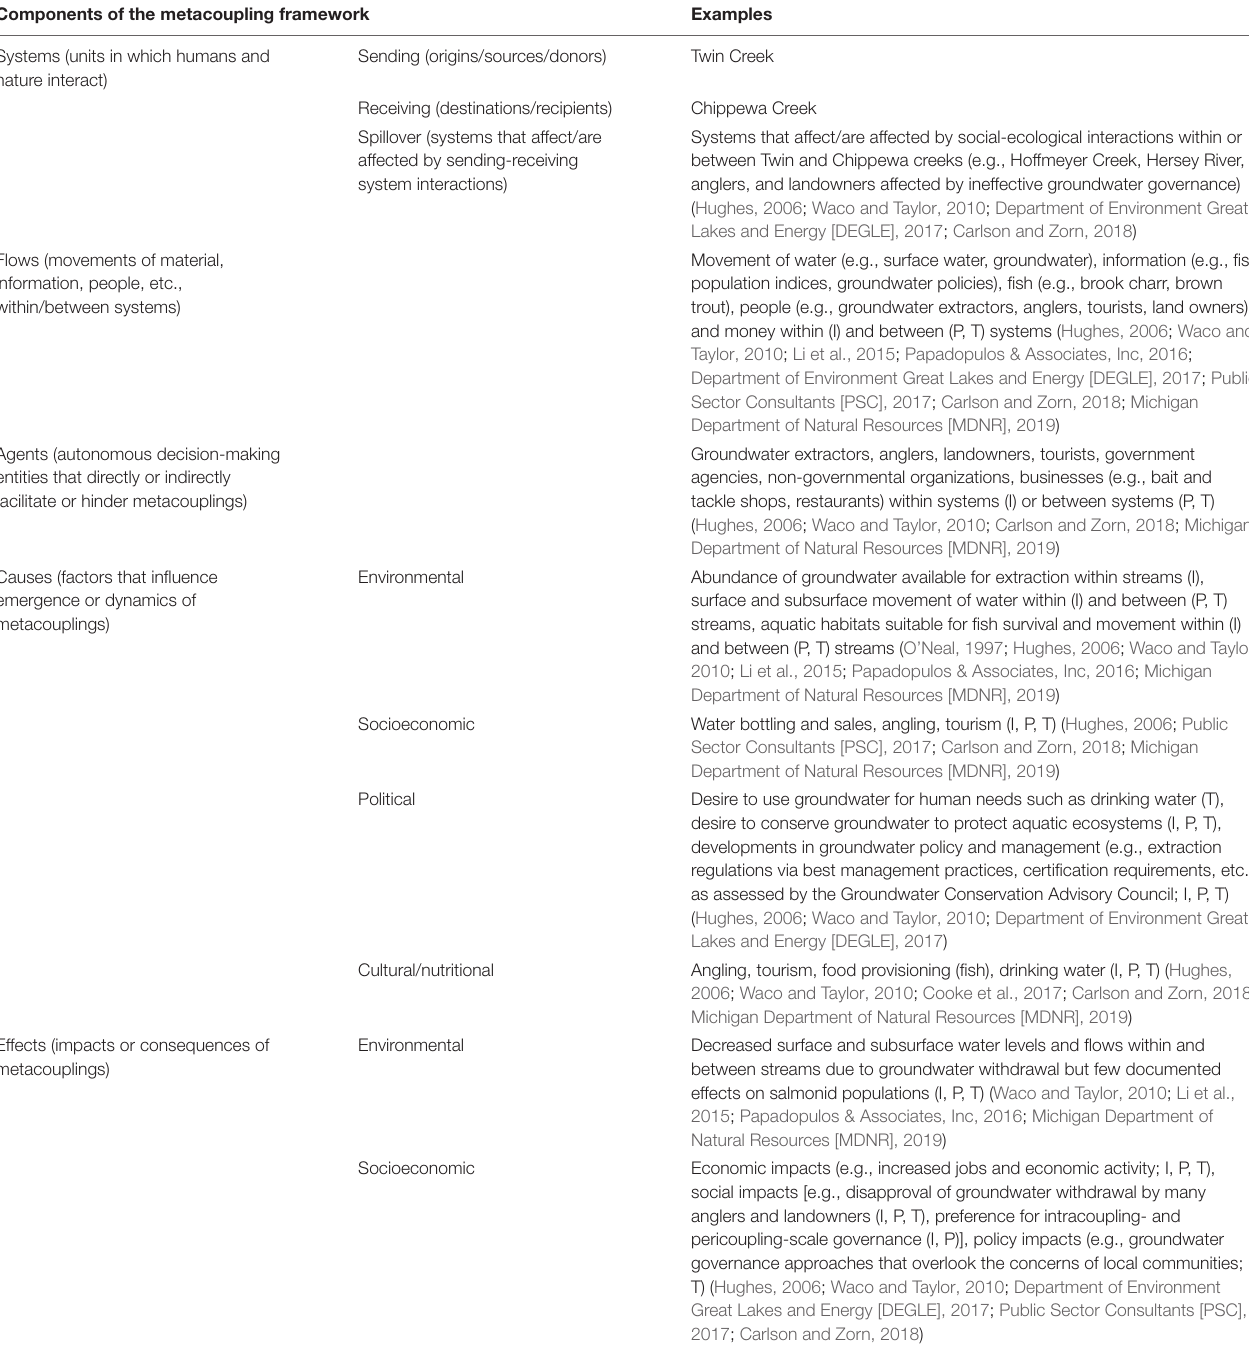
TABLE 1 | Summary of systems, flows, agents, causes, and effects associated with metacouplings involving Michigan stream salmonid fisheries. Intracoupling, pericoupling, and telecoupling processes are denoted by I, P, and T, respectively. Components of the metacoupling